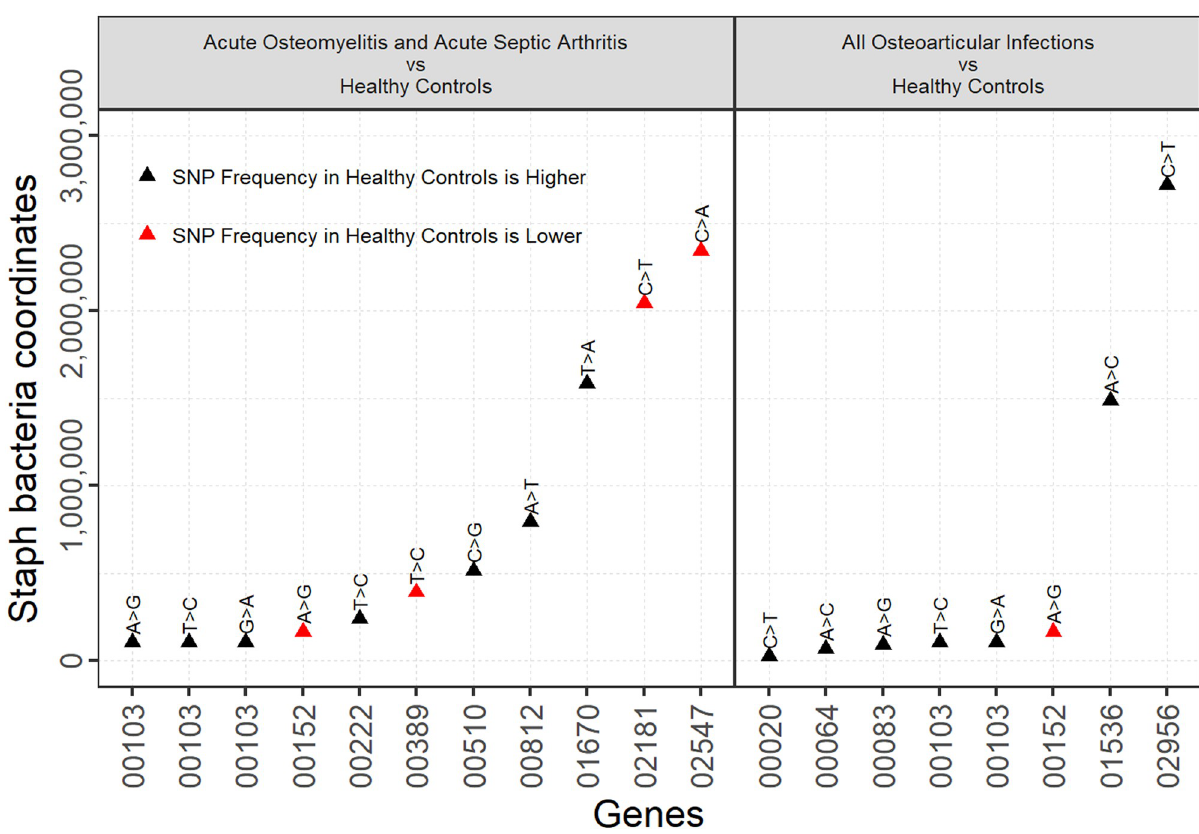
Fig 3. Plot of virulence gene mutations in Staphylococcus aureus isolates from children with osteoarticular infections legend (gene function). 00103---ABC transporter permease/nickel cation transport. 00152---isochorismatase-domain containing protein. 00222---TagB/teichoic acid biosynthesis. 00389---Superantigen-like protein. 00510---Serine acetyltransferase. 00812---clfA (clumping factor A). 01670---cytidine deaminase. 02181---PVL-like protein. 02547---molybdenum ABC transporter. 00020---WalK/WalR regulon. 00064---norG regulator (antibiotic efflux pump). 00083---sbnl (serine kinase/siderophore biosynthesis). 01536---sub-unit of the clp protease. 02956---ompR family/braB/BceR antibiotic